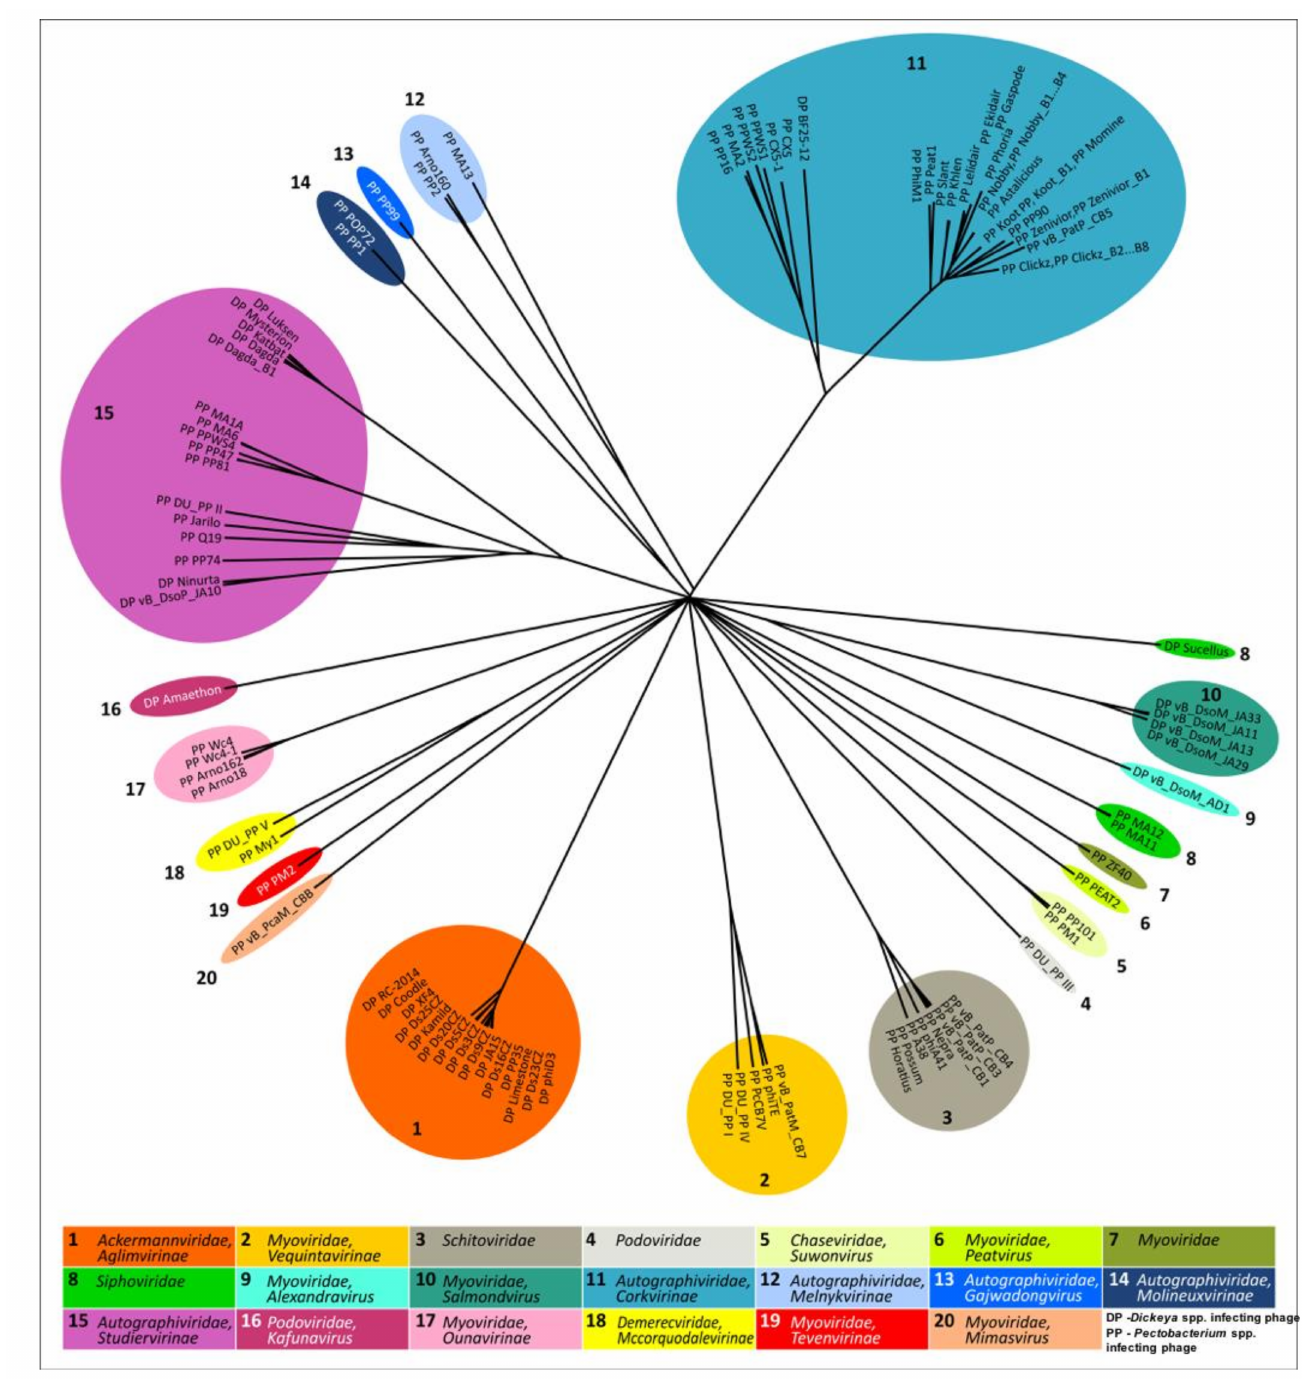
Figure 2. The tree representing the BIONJ clustering based on the VIRIDIC intergenomic similarity values of 108 GenBank SRP bacteriophage genomes. The phage taxonomy is indicated in the